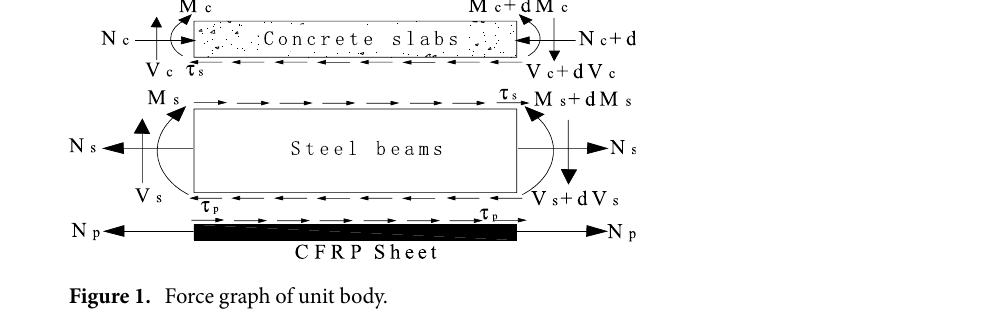
Figure 1. Force graph of unit